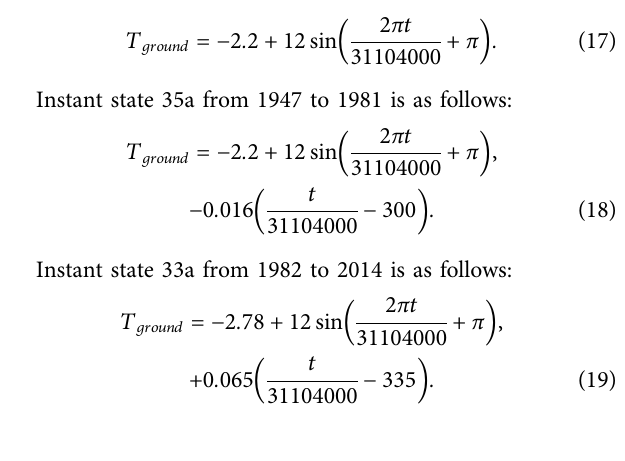
Frontiers in Earth Science |